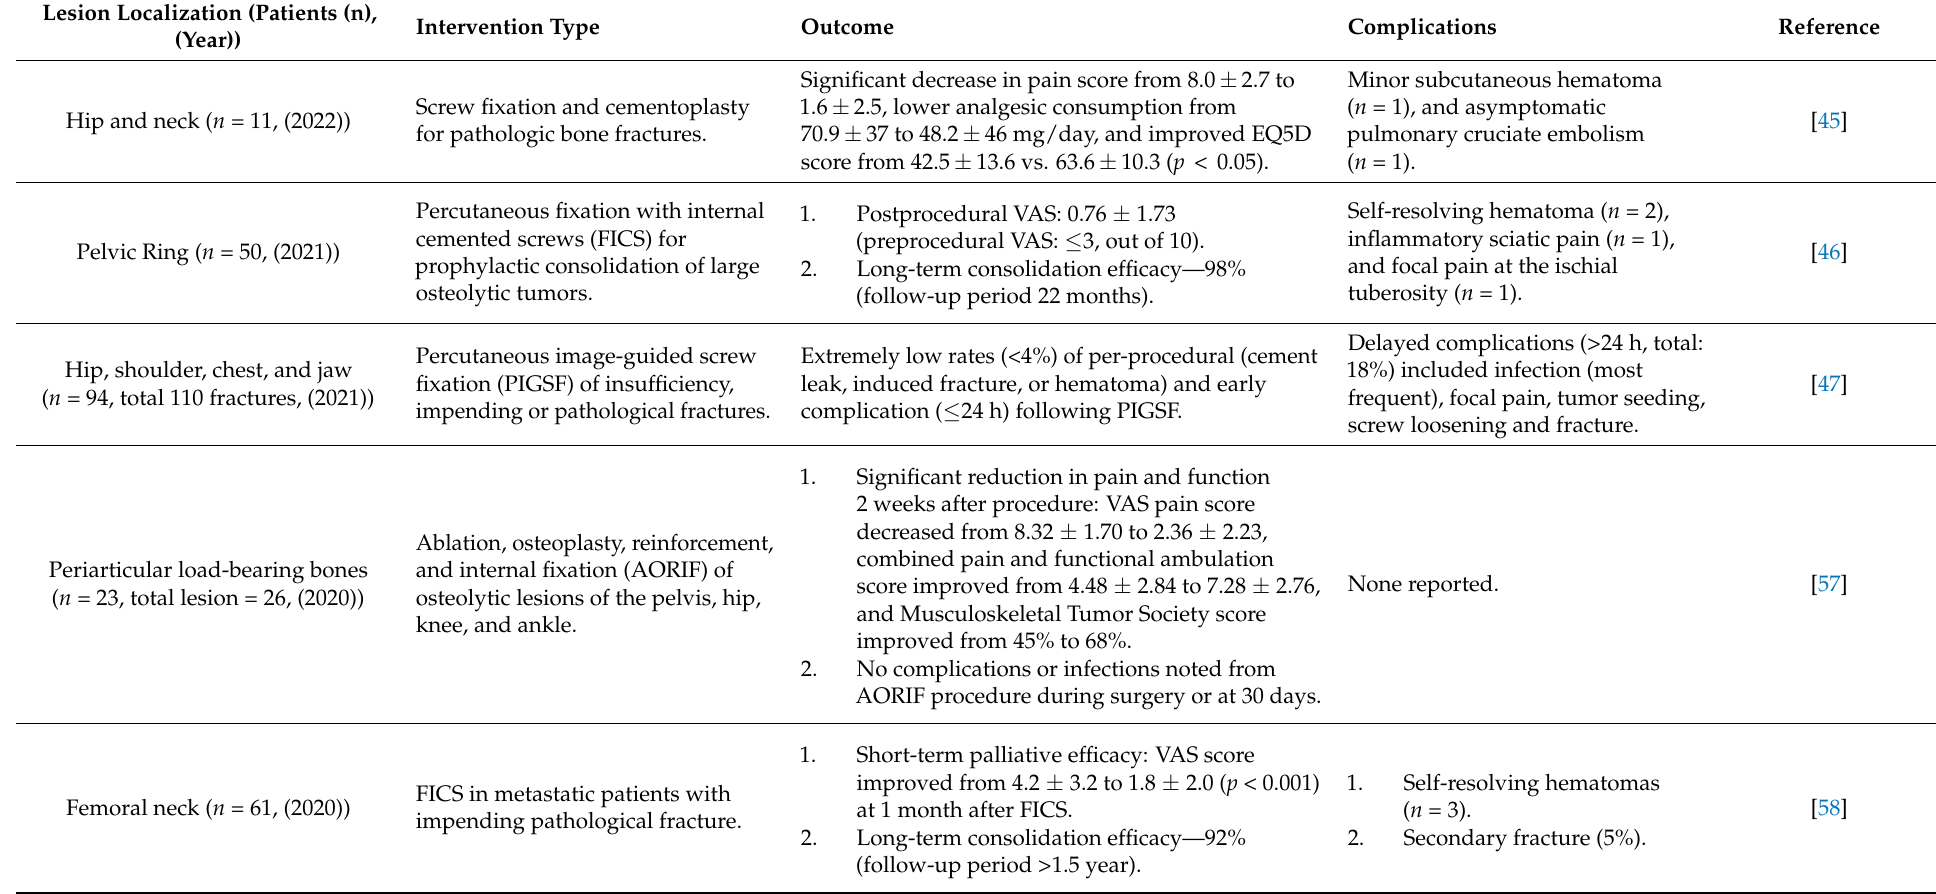
Table 3. Summarized results of recent studies involving percutaneous osteoplasty with/without reinforcement for management of bone metastases. Lesion Localization (Patients